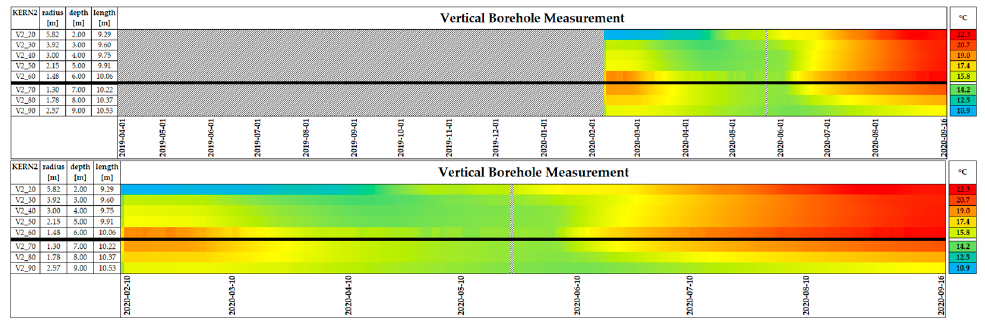
Figure 22. KERN2 vertical borehole temperature profile.